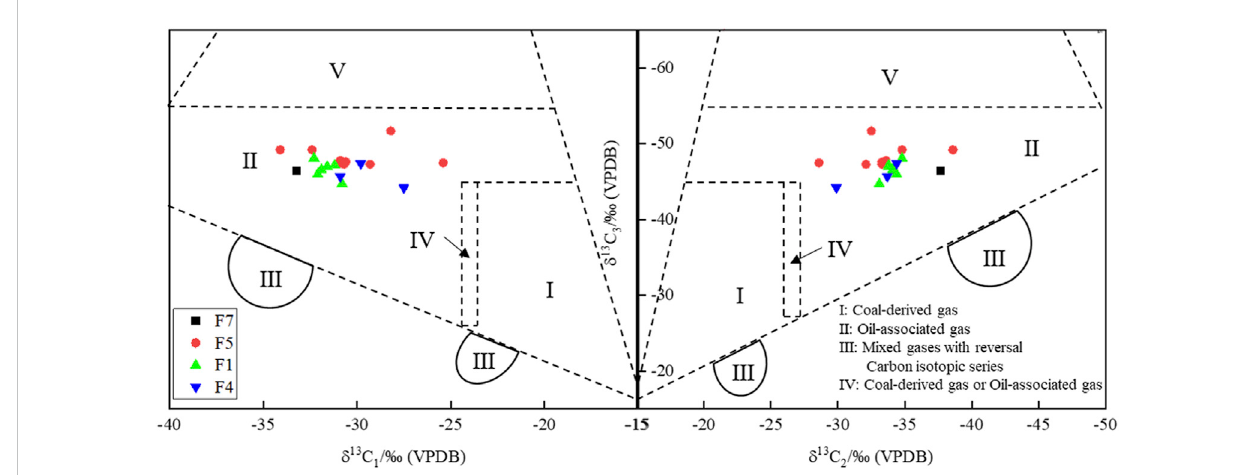
FIGURE 4 Genetic identi fi cation of alkane gases showing that the natural gases from the Shunbei area along the exhibits the characteristics of oil-associated gas (Modi fi ed from Dai et al., 1992).